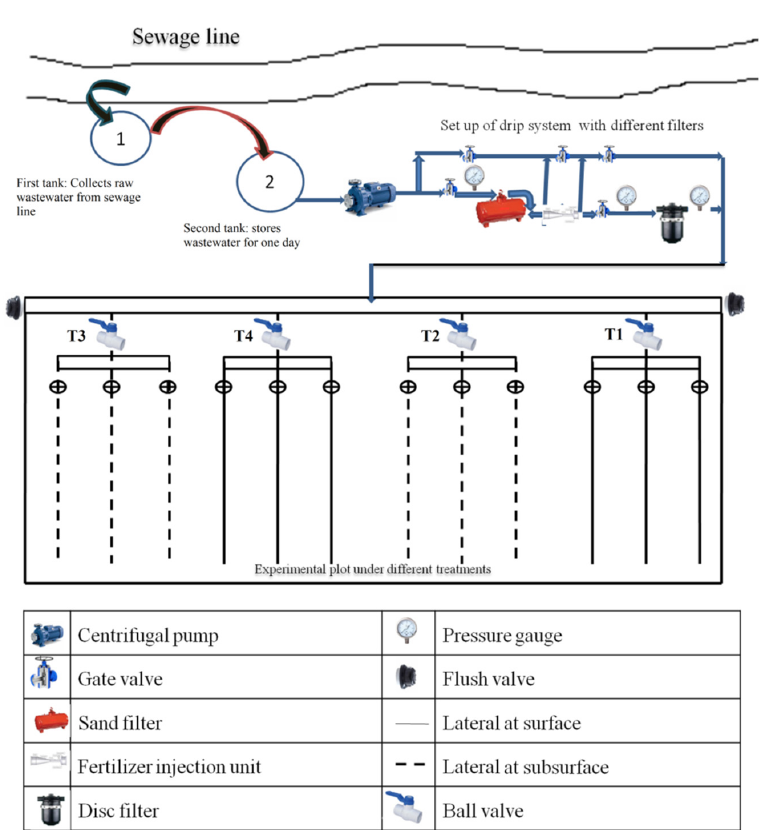
Figure 3. Setup of a drip irrigation system and layout of experimental plot under different Table T1 and T2 are the inline laterals under surface and subsurface placement, whereas T3 and T4 are the bioline laterals under subsurface and surface placement, respectively.